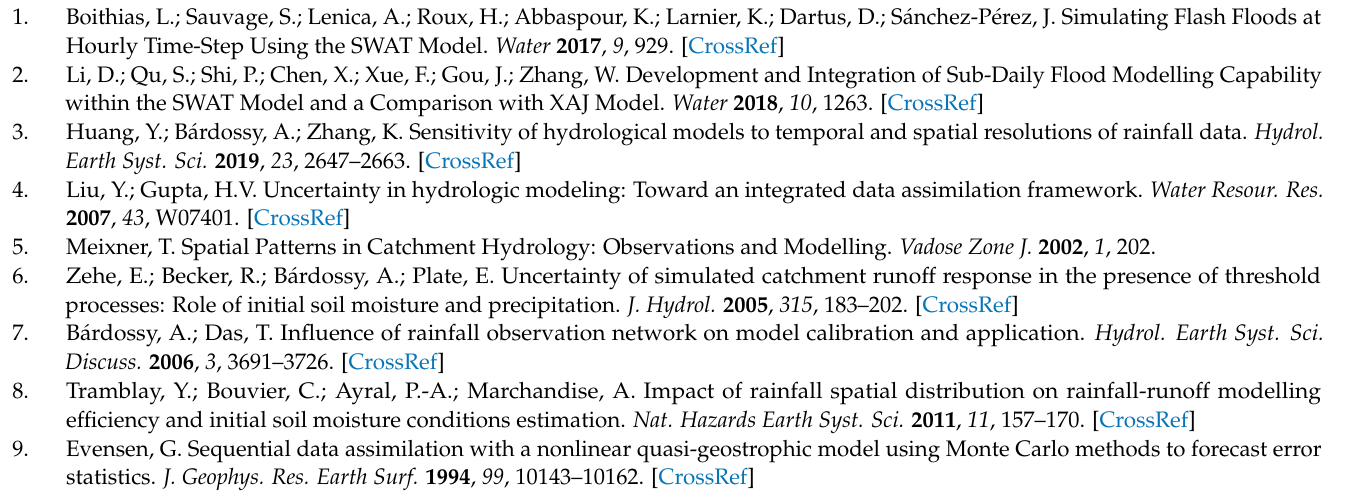
Figure A1. Comparisons of the observed, Q obs , and simulated, Q sim , discharge (lower panel) for the calibration and validation periods by the HBV model at the (a) WWQ, (b) DPL and (c) CTG basins. Table A2. Full name of the abbreviated nouns used in the study.